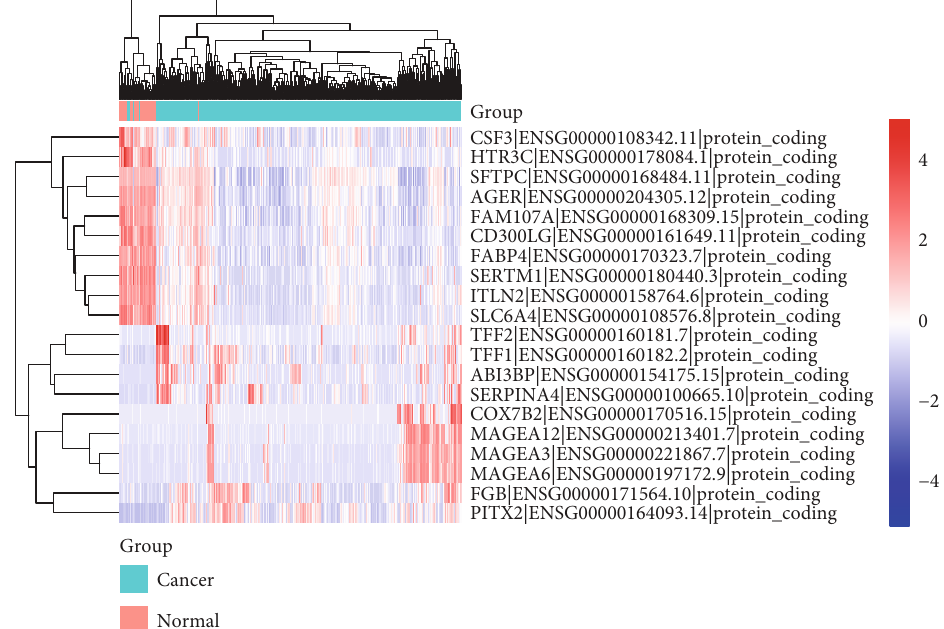
Figure 2: The expression of mRNAs in EC tissues and normal tissues from GEPIA analysis. The top 10 variation mRNAs were showed in the heat map.